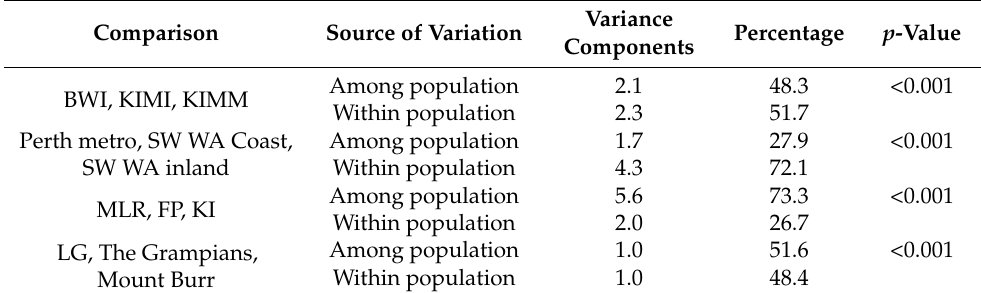
Table 1. Hierarchical AMOVA of mitochondrial DNA performed by grouping sampling sites into re- gions. Barrow Island (BWI), Kimberley Island (KIMI), Kimberley mainland (KIMM), south west Western Australia (SW WA), Mount Lofty Ranges (MLR), Fleurieu Peninsula (FP), Kangaroo Is- land (KI), Lower Glenelg (LG). Variance Percentage p -Value Comparison Source of Variation Components Among population 2.1 48.3 <0.001 BWI, KIMI, KIMM Within population 2.3 51.7 Perth metro, SW WA Coast, Among population 1.7 27.9 <0.001 SW WA inland Within population 4.3 72.1 Among population 5.6 73.3 <0.001 MLR, FP, KI Within population 2.0 26.7 Among population 1.0 51.6 <0.001 LG, The Grampians, Within population 1.0 Mount Burr